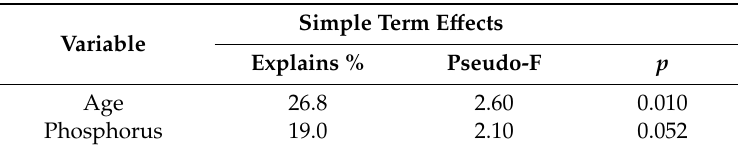
Figure 3. ( a ) Detrended correspondence analyses and ( b ) canonical correspondence analysis (CCA) ordination plots based on Hellinger-transformed abundance data of mycorrhizal fungal species at the order level of fungal communities associated with three age groups of Pinus patula stands in the study area in Ethiopia. Plots shown in the same color are in the same stand (yellow, plots in the 5-year-old stand; black, plots in the 11-year-old stand; red, plots in the 36-year-old stand). Edaphic variables are shown in green. The percentages of cumulative explained variation by each axis are shown in ( b ). Table 4. Canonical correspondence analysis based on simple term e ff ects showing the significance ( p < 0.05) of edaphic variables when considering the Hellinger transformed data of ectomycorrhizal species at the order level of fungal community in the study